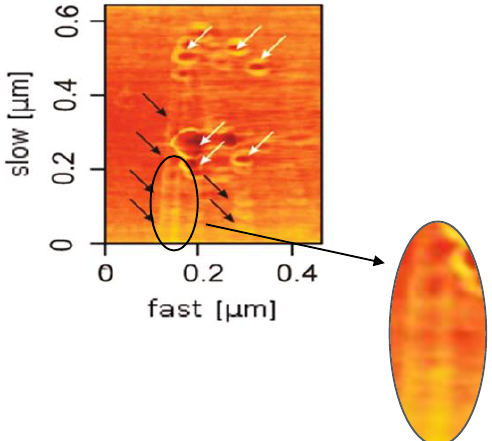
diameter of DNTs show confirms the fabrication of DNATs.